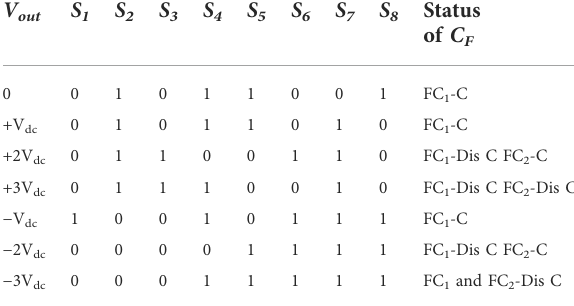
TABLE 1 Switching sequence for the proposed 8S7L-TTB